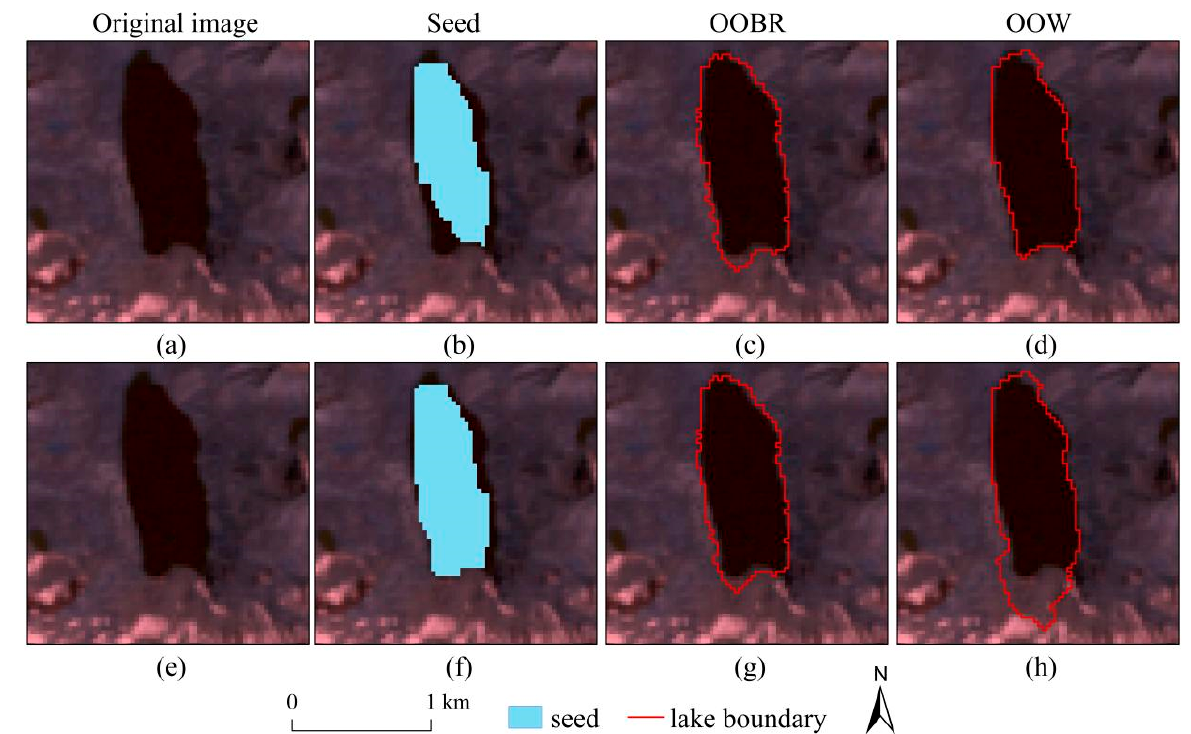
Figure 15. Results of the method of OOBR and OOW with different feature rule sets image: ( a , e ) are the original remote sensing images from the experimental area; ( b – d ) are the results with the feature rule set in Figure 14a; ( f – h ) are the results with the feature rule set in Figure